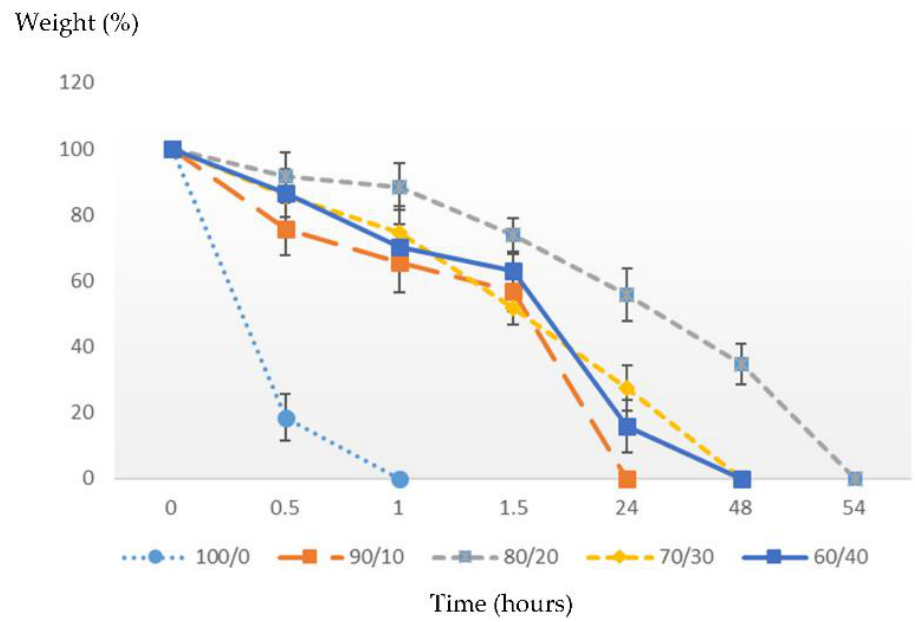
Figure 4. Result of the degradation of gelatin/Na 2 Ti 3 O 7 biomedical scaffolds. (n = 20).